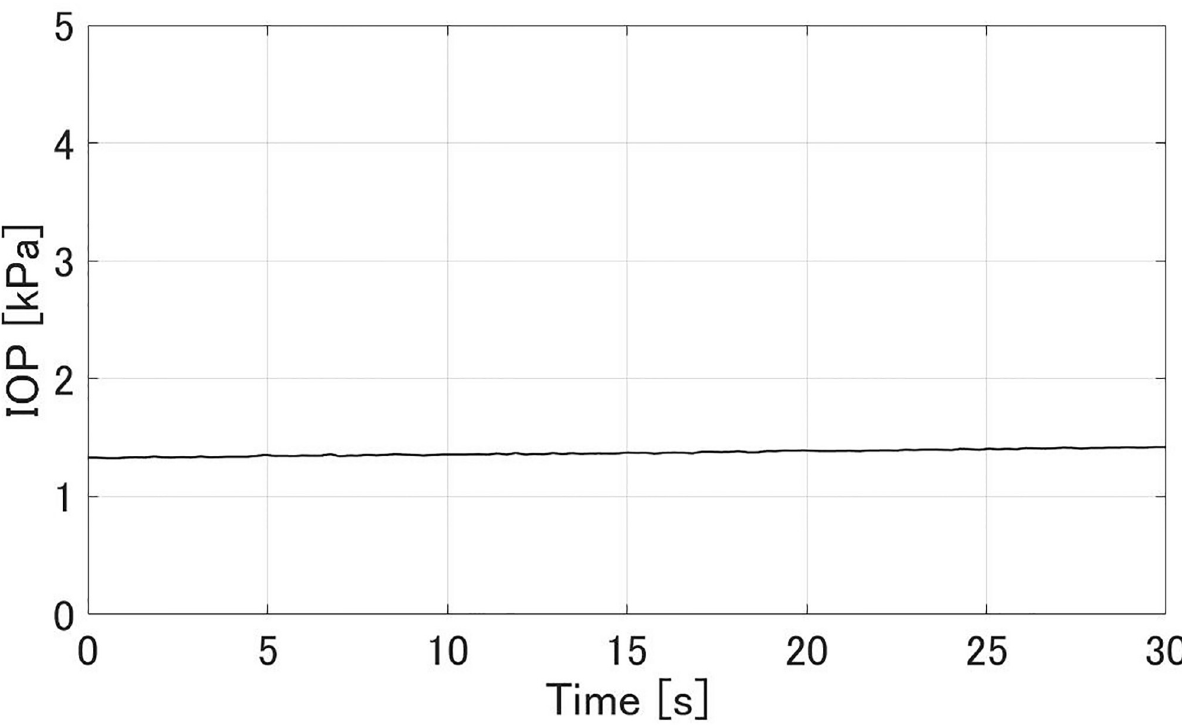
Fig 11. An experimental result of the IOP p + after cleaving the TM membrane and adhesively closing the small incised part in the cornea. The sampling interval was 0.26 s. p + was 1.37 ± 0.05